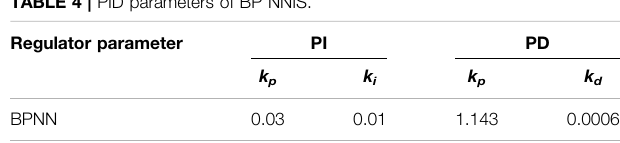
TABLE 4 | PID parameters of BP